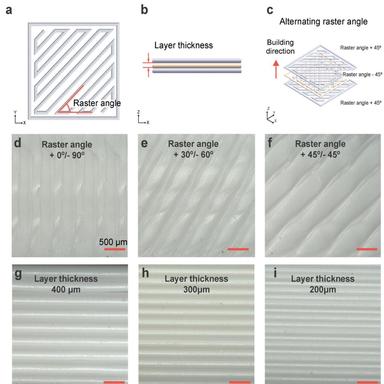
Process parameters for additive-manufactured binder-coated zirconia: (a) raster angle, (b) layer thickness, and (c) alternating the raster angle between layers. Test specimen layers printed using raster angles of (d) + 0◦/− 90◦, (e) + 30◦/− 60◦, and (f) + 45◦/− 45◦. Test specimens printed using layer thicknesses of (g) 400 µm, (h) 300 µm, and (i) 200 µm.